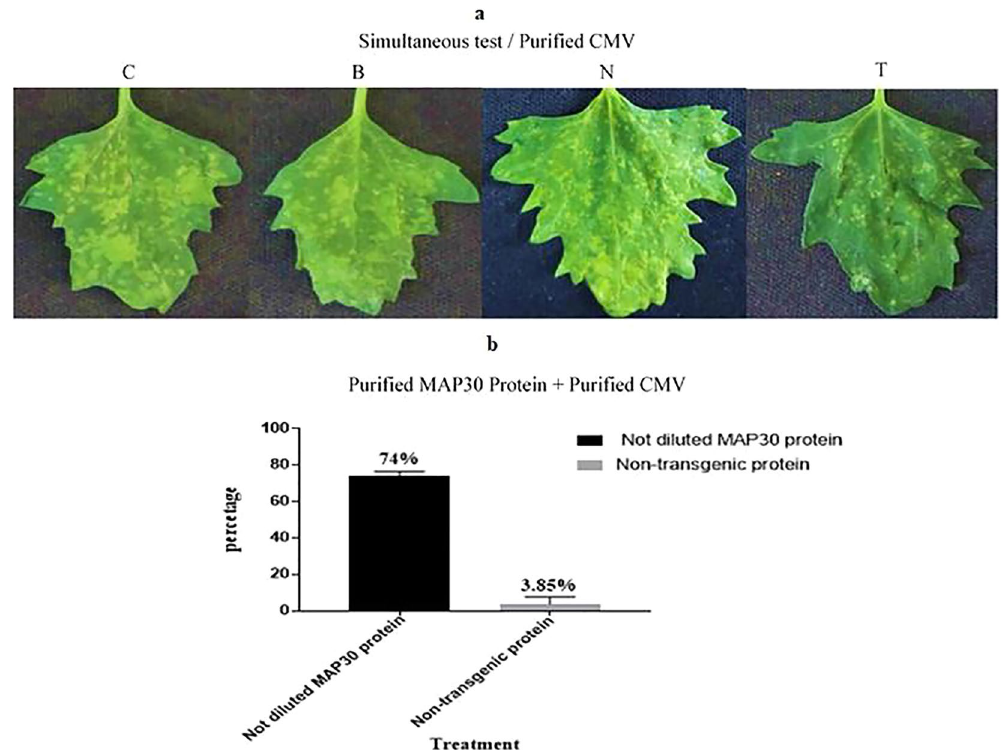
Figure 10. The inoculation of C. quinoa seedlings simultaneously with purified CMV and rMAP30 or non-transgenic protein. The extraction buffer (phosphate buffer) was considered as one of the negative controls (Table 4). There were 16 replicates for each test. (a) The assays performed by undiluted rMAP30 (T), extraction buffer (B), non-transgenic protein (N), and CMV (C). (b) Viral infection intensity graph for non-diluted transgenic rMAP30 versus non-transgenic protein and extraction buffer. As it could be observed in the figures and the chart, rMAP30 can control the infection up to 74% in the undiluted stats. Although the extraction buffer, non-transgenic protein, as the control samples, were implemented in order to achieve a better understanding, that they did not influence the viral infection reduction. In addition, it was found that the intensity of viral spots on the controls inoculated leaves was highly similar to the virus-inoculated